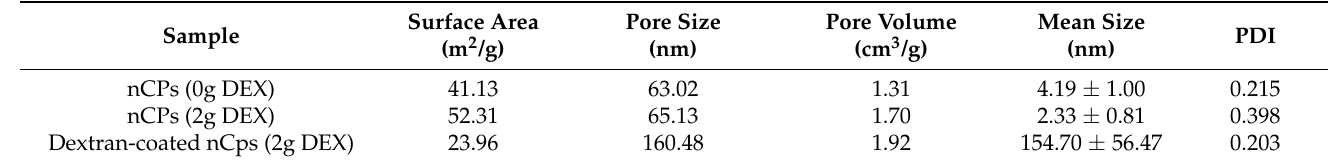
Table 1. Physicochemical properties of the nCPs (0g DEX), nCPs (2g DEX) and dextran-coated nCPs (2g